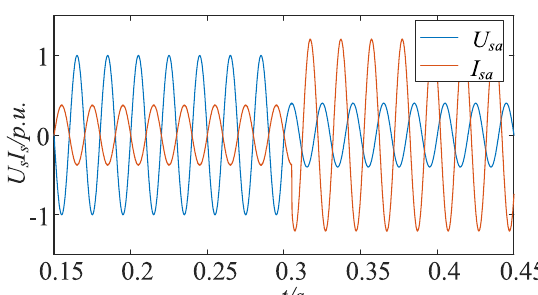
Fig. 11 Phase A voltage and current when the voltage drops in the inverter state